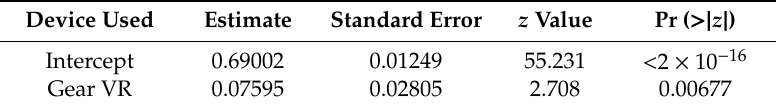
Table 9. Logistic regression results of the device used.